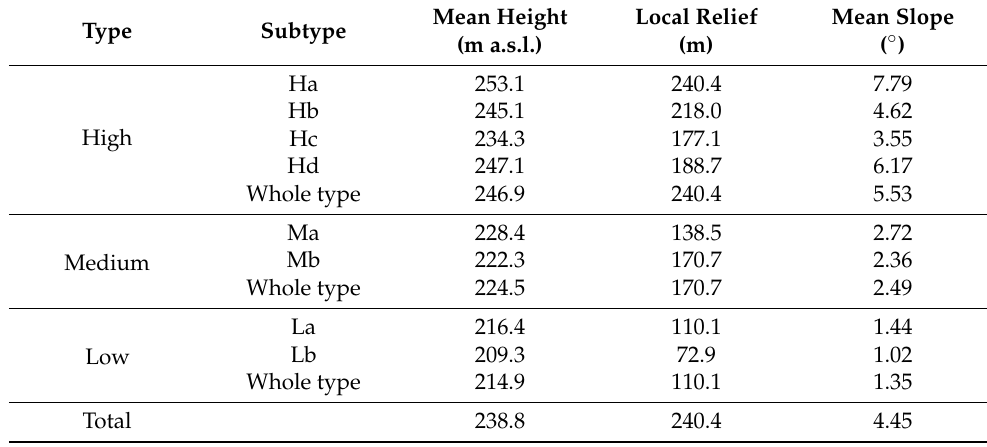
Figure 4. Segments of analyzed loess patches grouped in 3 main relief types. Table 2. Basic morphometric characteristics of relief types and subtypes.